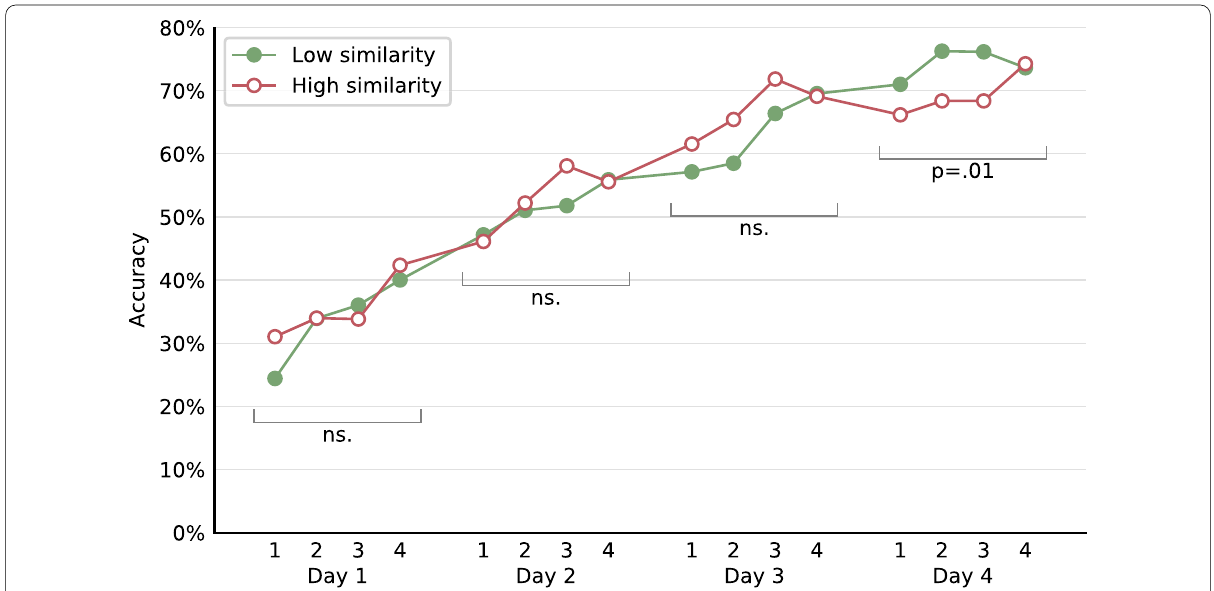
Fig. 4 The effect of similarity on accuracy in each response attempt during the training rounds. The improvement was nearly monotonous from day to day, with a significant effect of similarity only on the last training day—the day most sensitive to long‑term memory